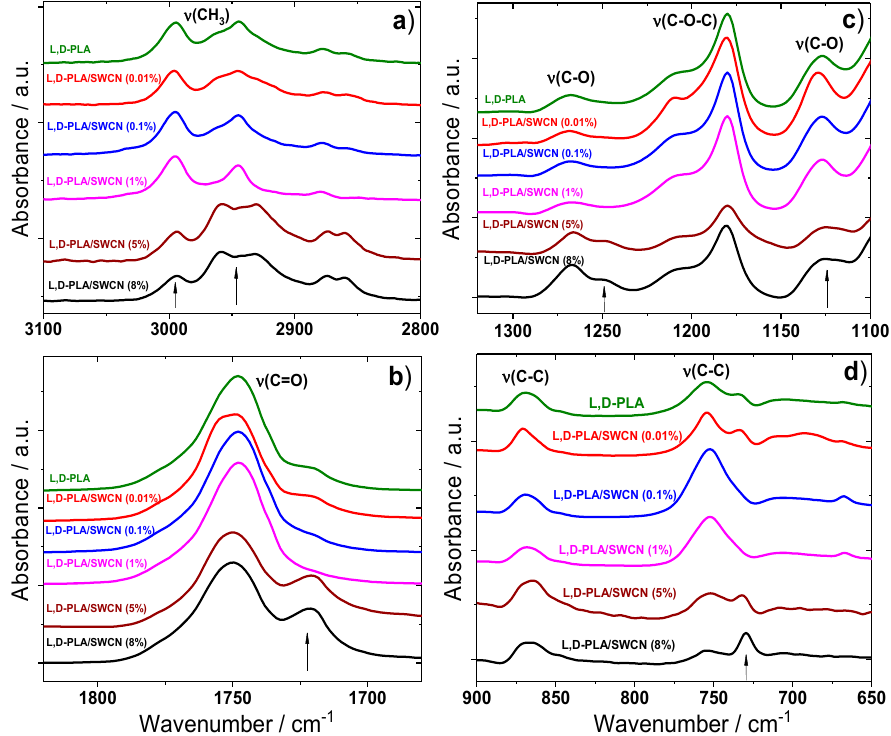
Figure 15. FT-IR spectra of L , D -PLA and L , D -PLA/SWCN composites with different compositions in four different spectra ranges: ( a ) 3100–2800, ( b ) 1820–1680, ( c ) 1320–1100 and ( d ) 900–650 cm − 1 . The bands which change significantly are marked with arrows.